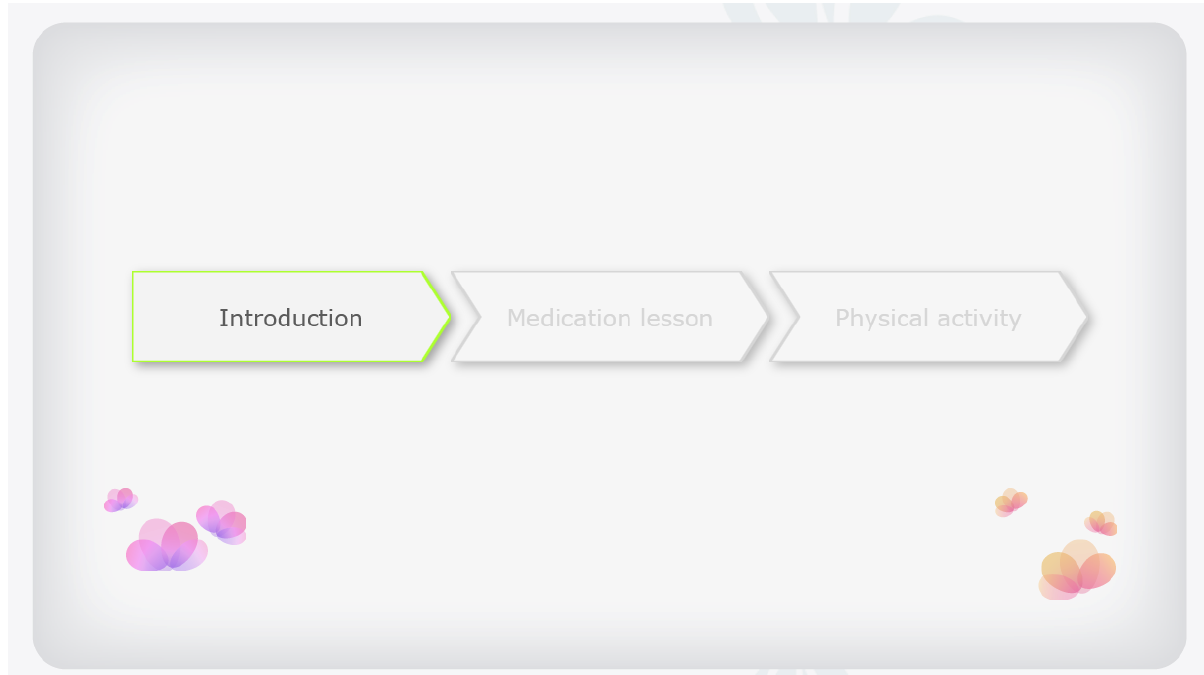
Figure 1. Screenshot of the main menu from